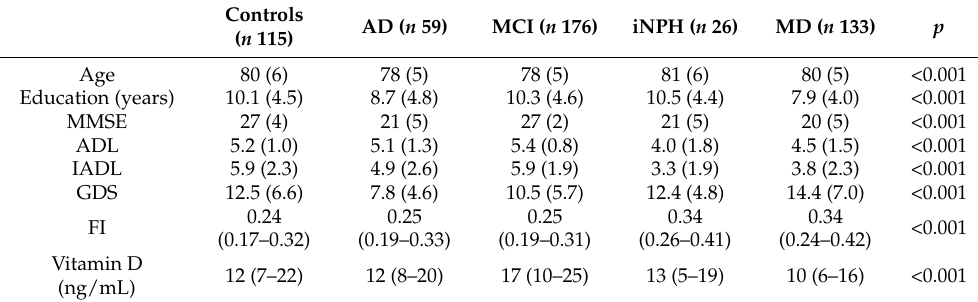
Table 3. Characteristics and vitamin D levels of the subjects categorized on